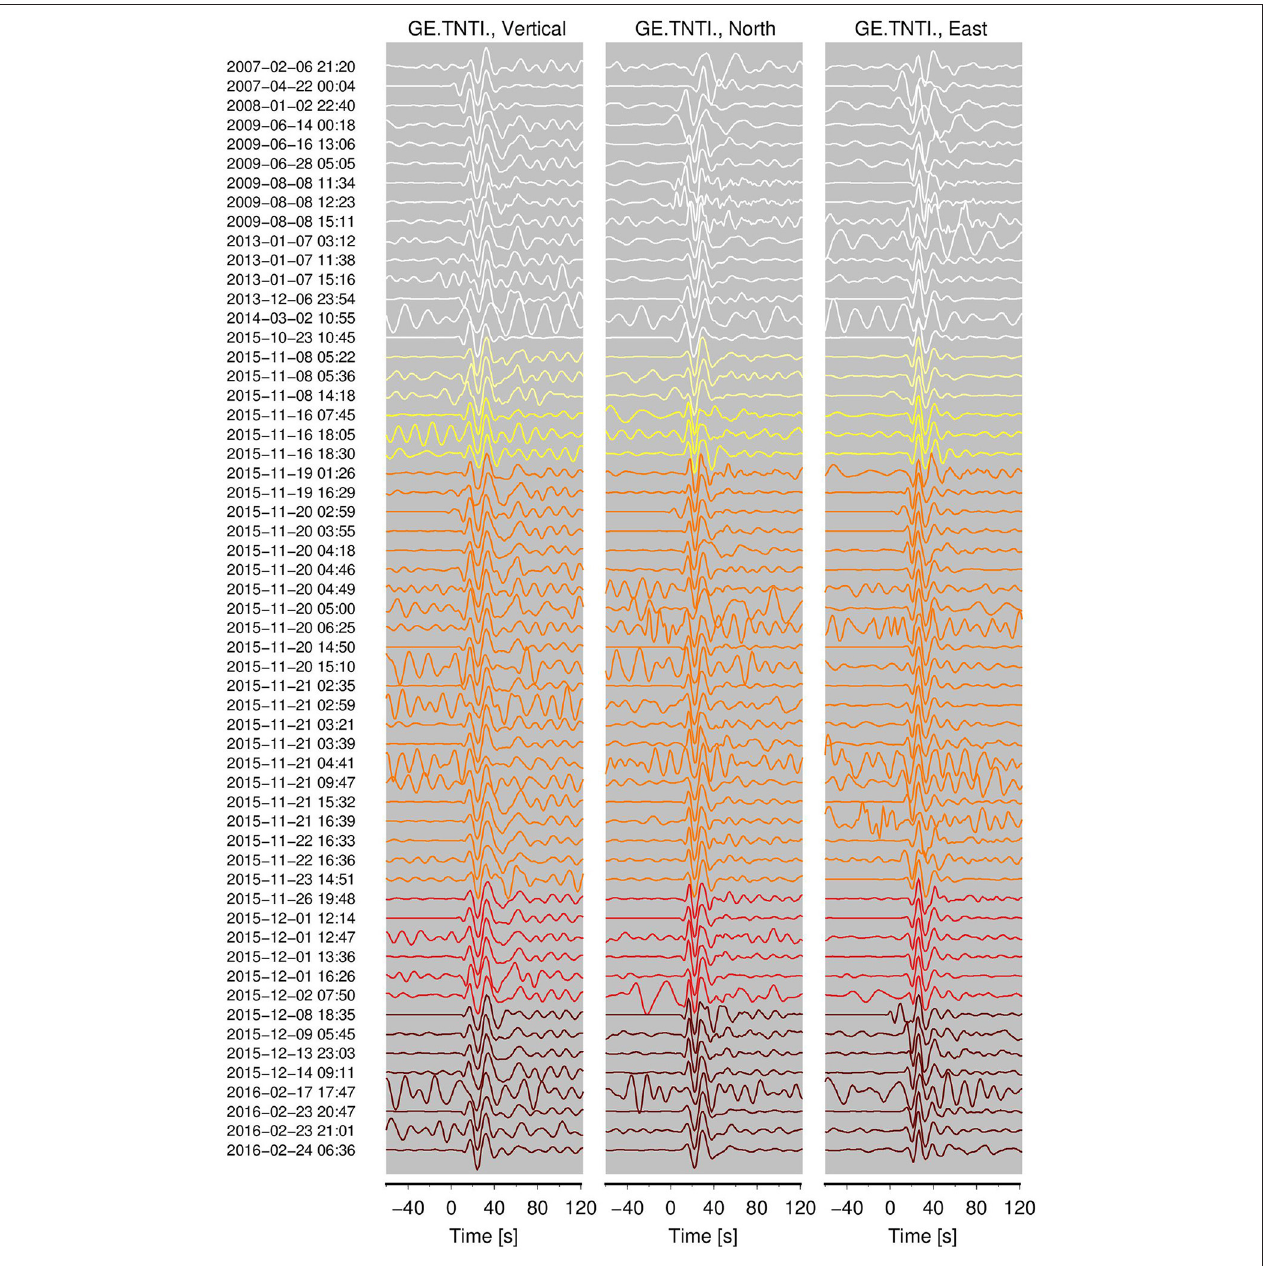
FIGURE 6 | Waveform signals at TNTI station for relocated events between 2007 and 2016. The signals are band-pass filtered in the range 0.04–0.08Hz. Color code as in Figure 3